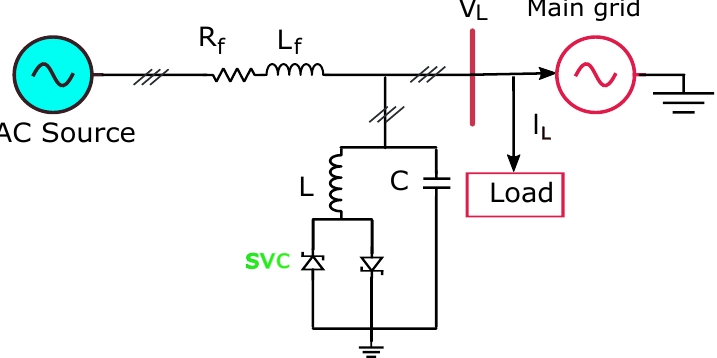
Figure 2. Typical configuration of SVC used for mitigation of voltage sag in AC grid system.